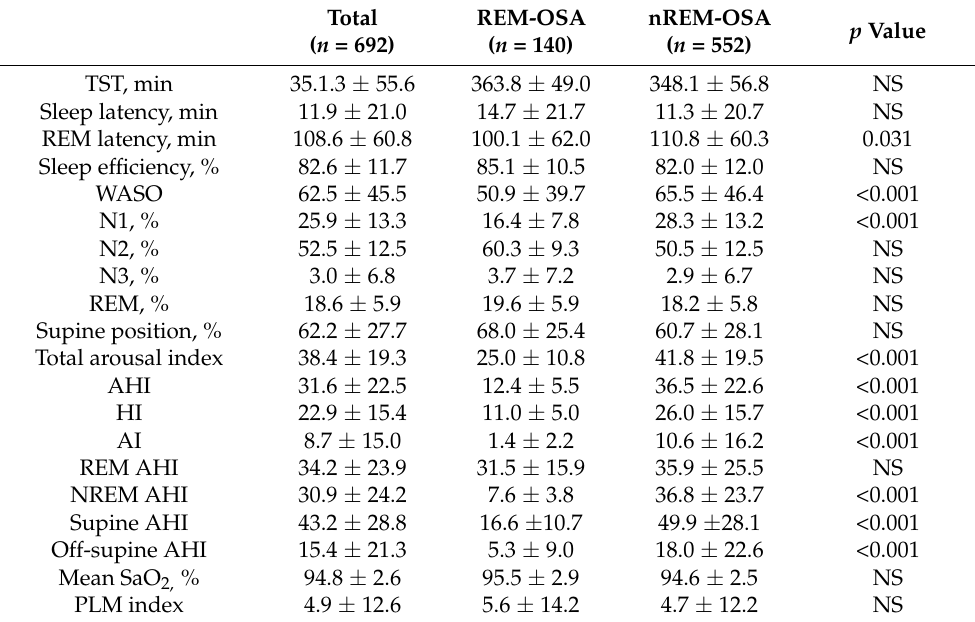
Table 2. Polysomnographic data for the entire group and REM-OSA and nREM-OSA patients.